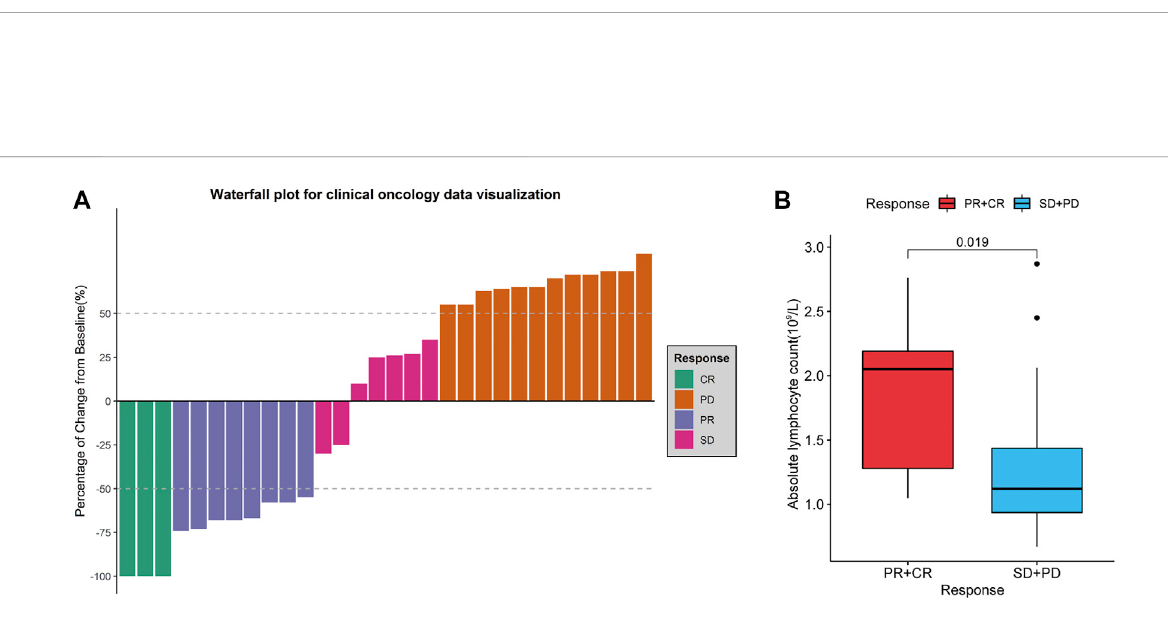
FIGURE 11 Treatment evaluation of 30 r/rDLBCL patients. (A) Waterfall plot for treatment evaluation. (B) Absolute lymphocyte count (ALC) in different treatment response groups. Wilcoxon test for comparison of ALC between the two